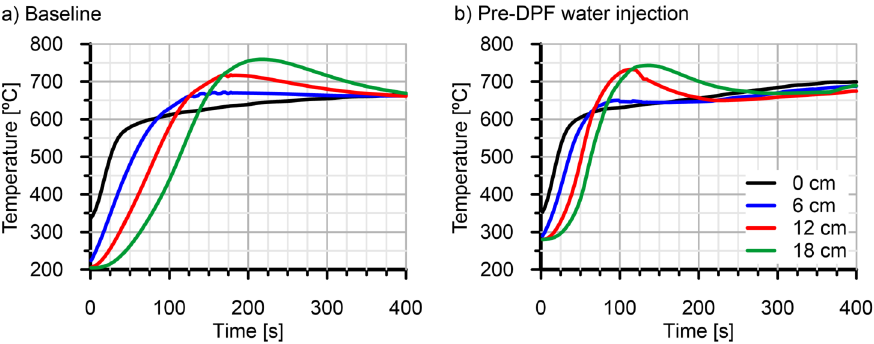
Figure 15. Gas temperature evolution during the regeneration process in different locations of the